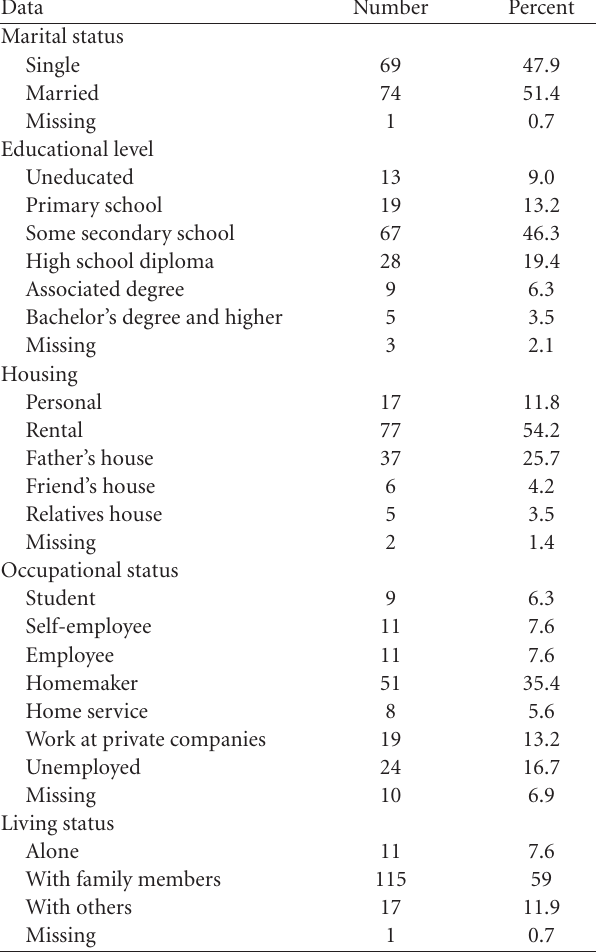
Table 2: Childhood trauma and HIV attitude among Iranian fe- male sex workers who have sex with injecting drug users ( n =